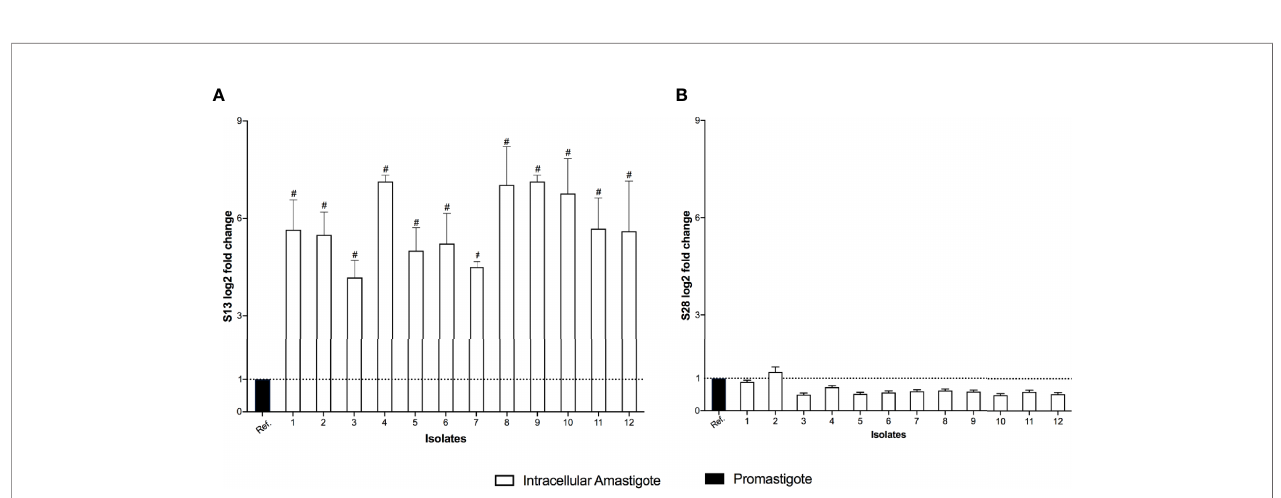
FIGURE 4 | Subtilisins differential gene expression. The real-time quantitative PCR results show the relative quanti fi cation values of subtilisin 13 (S13 log2 fold change) (A) and subtilisin 28 (S28 log2 fold change) (B) . Actin and protein S8 were used as endogenous controls. The DD Ct value of each subtilisin gene was calculated pair-to- pair between the reference sample (Ref.) and intracellular amastigotes. The dashed line indicates the reference sample relative quanti fi cation level = 1. The graph presents the mean of two independent experiments performed in triplicate. Statistical difference is represented by # p ≤ 0.0005.